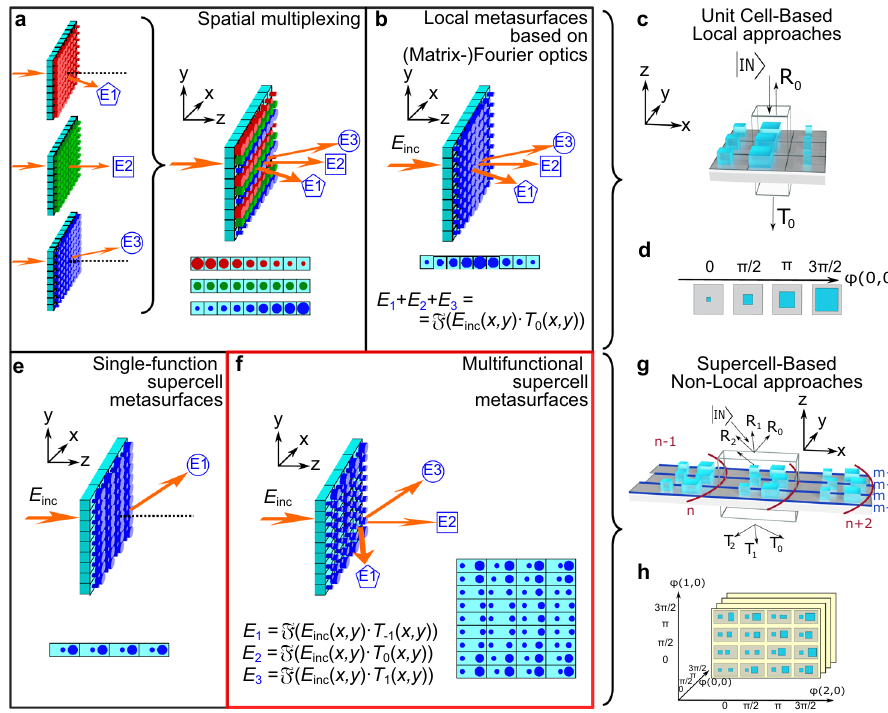
Fig. 1 The generalized supercell metasurface concept. a – c Local metasurfaces methods. Multiple functions can be created by either a interleaving cells from different metasurfaces or b exploiting Fourier optics and adding together the amplitude and phase pro fi les required for each function. The complex amplitudes can be replaced by Jones matrices to achieve polarization control (Matrix Fourier Optics). Both methods have low ef fi ciencies for large de fl ection angles due to the locality of their unit cells. c Illustration of a sub-wavelength unit cell of a local metasurface. d Example of traditional metasurface libraries of subwavelength unit cells that relate the locally implemented phase shifts to the physical dimensions of the metaatom. e Traditional supercell metasurface based on an array of supercells designed for single functions such as metagratings. f The proposed extended supercell metasurface (SCMS) concept based on the independent control of phase and polarization at each position and to implement independent functions on each order. The far- fi elds associated to each of the functions are related via the Fourier transform to the phase pro fi le implemented on each order. g Unlike